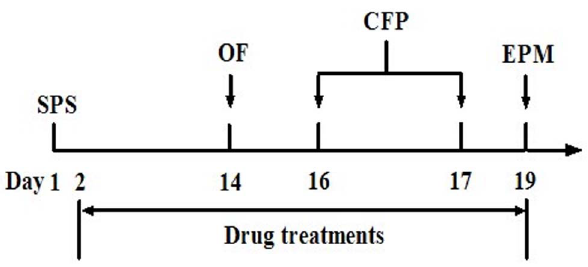
Figure 1. Treatment and behavioral tests schedules for the SPS model of PTSD. Animals were subjected to SPS on day 1. From days 14 to 19, animals were subjected to testing sessions composed of 3 different behavioral tests: OF, Open field; CFP, Contextual fear paradigm; and EPM, Elevated plus maze. Ser and midazolam were administered daily during the SPS exposure and behavioral assessments from days 2 to 19. PK11195, flumazenil or finasteride were administered 30 min before behavioral testing,